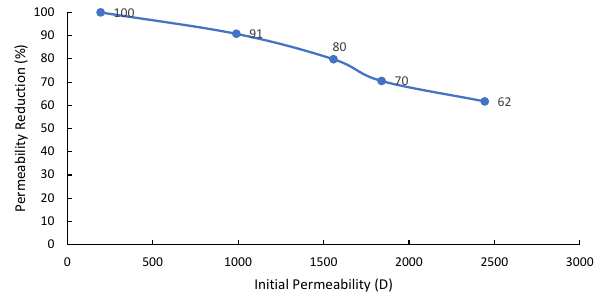
Fig. 8 Percent reduction in permeability following the application of stick-up